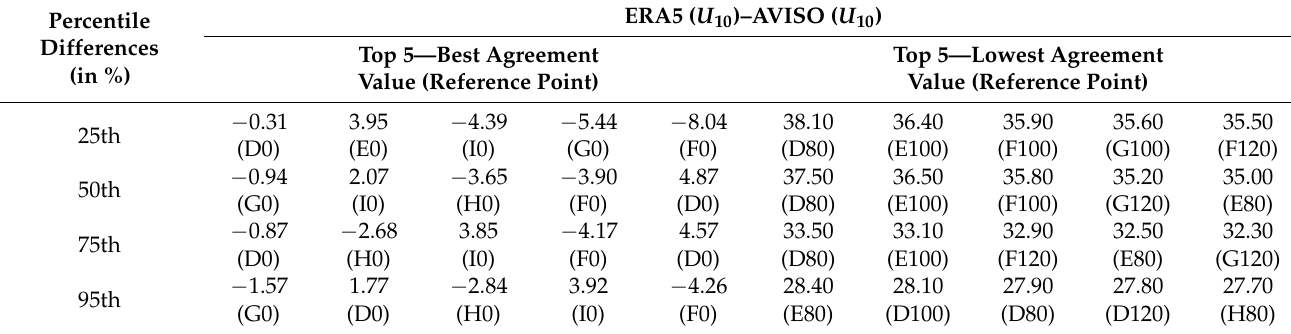
Table 2. Percentile comparisons between AVISO and ERA5 wind speeds at 10 m height above the sea level. The wind data are processed for the 7-year time interval 2013–2019, and a positive value indicates that the ERA5 wind speed is higher than that provided by